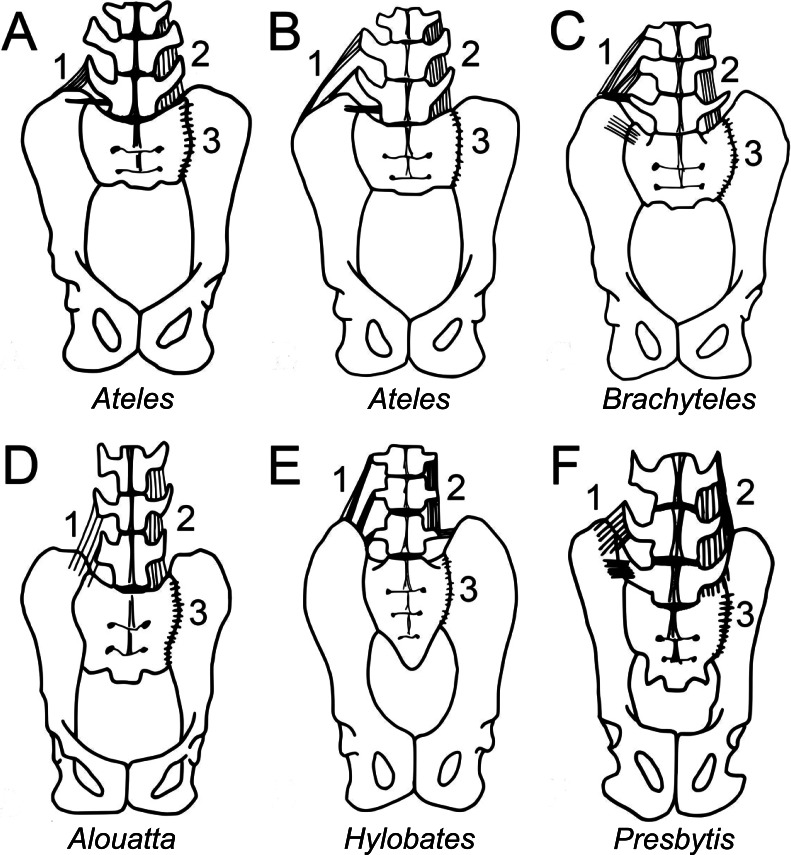
Iliolumbar (1), intertransverse (2), and iliosacral (3) ligament anatomy observed during primate dissections.Superficial ligaments are shown on the left, and deeper tissues shown on the right. Lumbar numbers are based on rib count, as articular facet orientation could not be observed without further destructive dissection. (A) Spider monkey (Ateles) [3 lumbars] and (B) spider monkey [4 lumbars]: Iliolumbar ligament spans L2 or L3 and the ilium, and a thin intertransverse ligament spans the transverse processes of L3 or L4, ilium and sacrum. These ligaments likely provide lumbar support, while permitting substantial mobility. (C) Muriqui (Brachyteles) [5 lumbars]: an iliolumbar ligament runs from L3, L4, and L5 to the ilium. A thin intertransverse ligament spans the transverse processes of the lumbar vertebrae. As in the spider monkey, these ligaments likely provide lumbar support, while permitting substantial mobility. (D) Howler monkey (Alouatta) [5 lumbars]: an iliolumbar ligament runs from L4 and L5 to the ilium. This tissue is narrower and covers less surface area on the ilium than the corresponding ligament in the spider monkeys, but serves a similar function. A thin intertransverse ligament spans the transverse processes of the lumbar vertebrae and runs from L5 to the ilium. (E) Gibbon (Hylobates) (5 lumbars): a thick iliolumbar ligament runs horizontally and obliquely between L3, L4, and L5 and the ilium. A thick intertransverse ligament run between each lumbar transverse process. The orientation of the ligamentous fibers is more similar to those of atelids than those of the langur, but the thickness was intermediate between the two. The ligamentous tissue would not have been as restrictive as in the langur. (F) Langur (Presbytis) [7 lumbars]: iliolumbar ligaments run from the 3 most caudal lumbar vertebrae to the ilium. A thick intertransverse ligament spans the transverse processes of the lumbar vertebrae and runs from L7 to the ilium to join both structures to the transverse processes of L6. Since the L7 is positioned deeply between the iliac blades, its motion is highly restricted. The ligamentous tissue of the langur is substantially denser than that of all the other specimens and would have restricted motion more substantially. The iliolumbar ligament is hypothesized to have developed in primates associated with stabilizing the back while upright or lordosing and is possibly formed by collagenation of the fibers of the quadratus lumborum (Luk, Ho & Leong, 1986; Pun, Luk & Leong, 1987). It has not been found in other quadrupedal animals like cats and dogs (Pun, Luk & Leong, 1987).